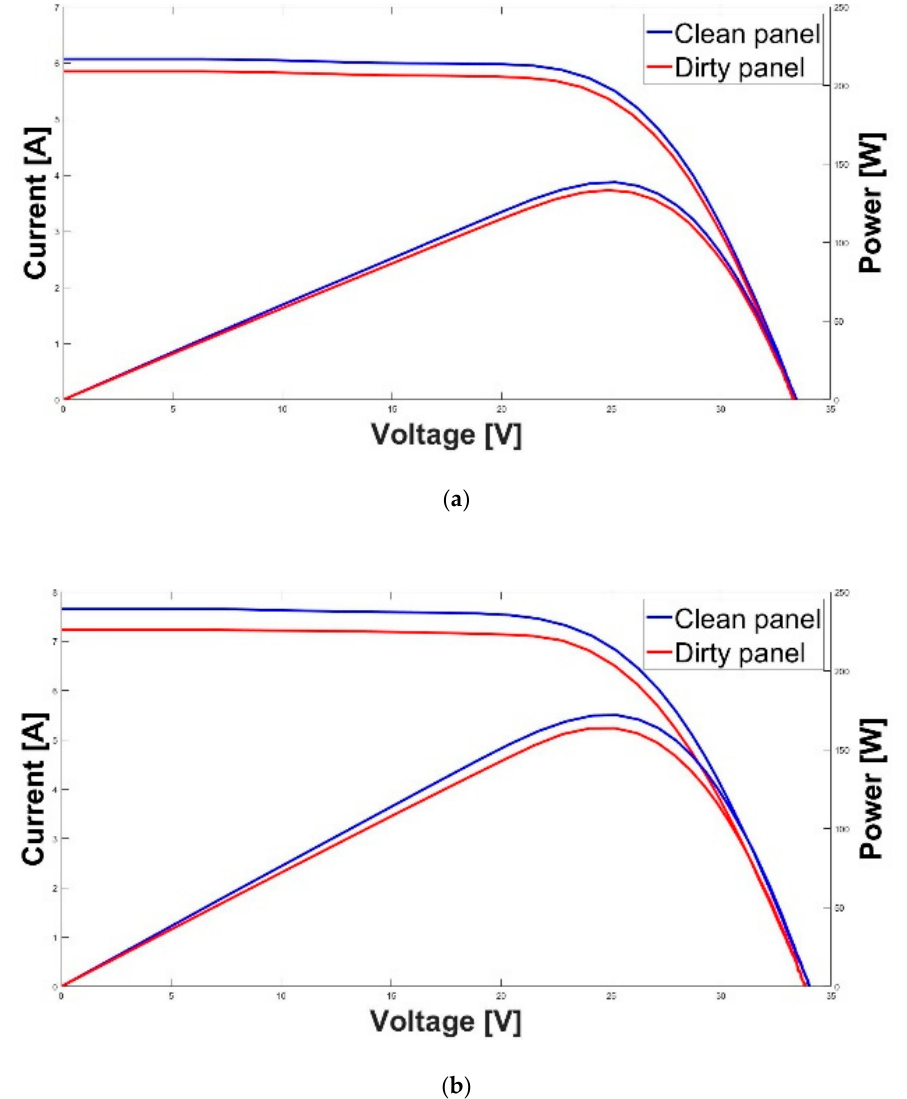
Figure 3. Curves obtained at local time: ( a ) on 17 January at 13:56 (clean module) and at 13:55 (dirty module); ( b ) on 14 March at 12:05 (clean module) and at 12:06 (dirty module).